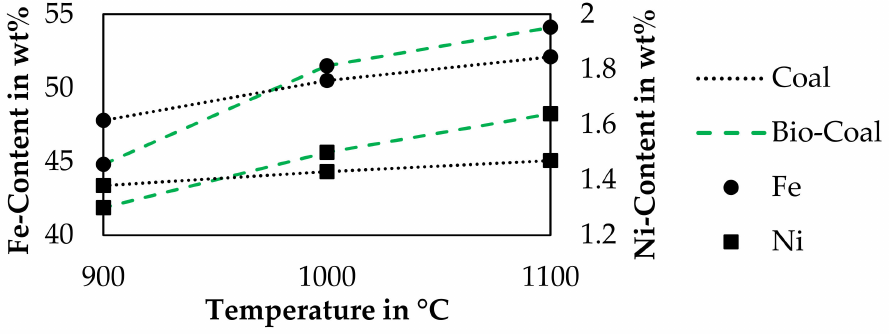
Figure 12. Iron- and nickel content after reduction of limonite with coal and bio-coal (based on data from